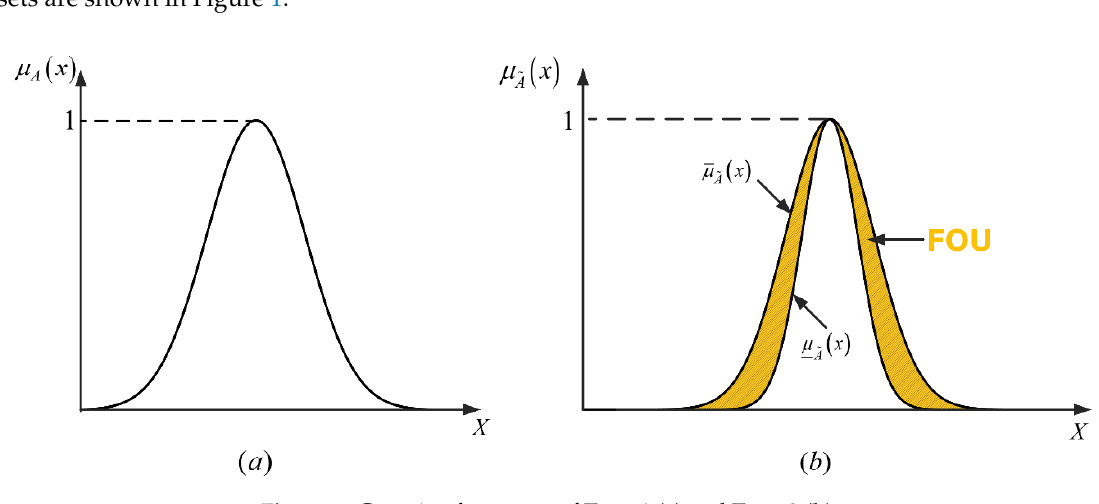
Figure 1. Gaussian fuzzy sets of Type-1 ( a ) and Type-2 ( b ).